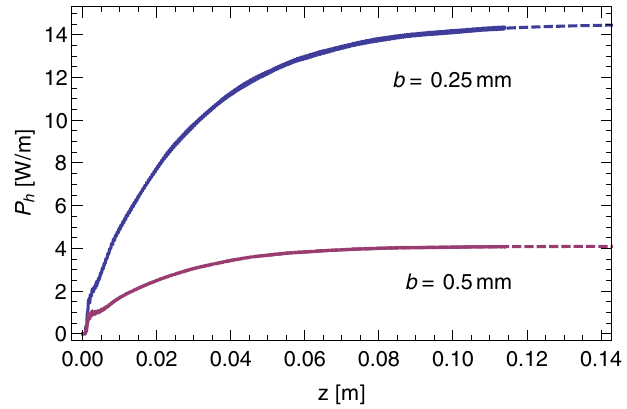
FIG. 15. Single plate: numerically obtained, Joule power calculations for beam offsets b ¼ 0 . 25 mm (blue) and b ¼ 0 . 5 mm (red). The beam traverses the plate from its beginning, at z ¼ 0 , to its end, at z ¼ 0 . 115 m. The dashed lines give extrapolation to steady state. Here Q ¼ 300 pC, f the driving charge is Gaussian with σ